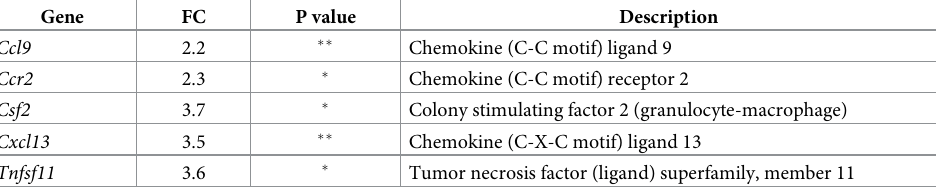
Fold Change (FC) in infected C5ar1 -/- mice (n = 4) relative to infected Balb/c mice (n = 4). P values are calculated using the Student t-test � P value � 0.05 �� P value �